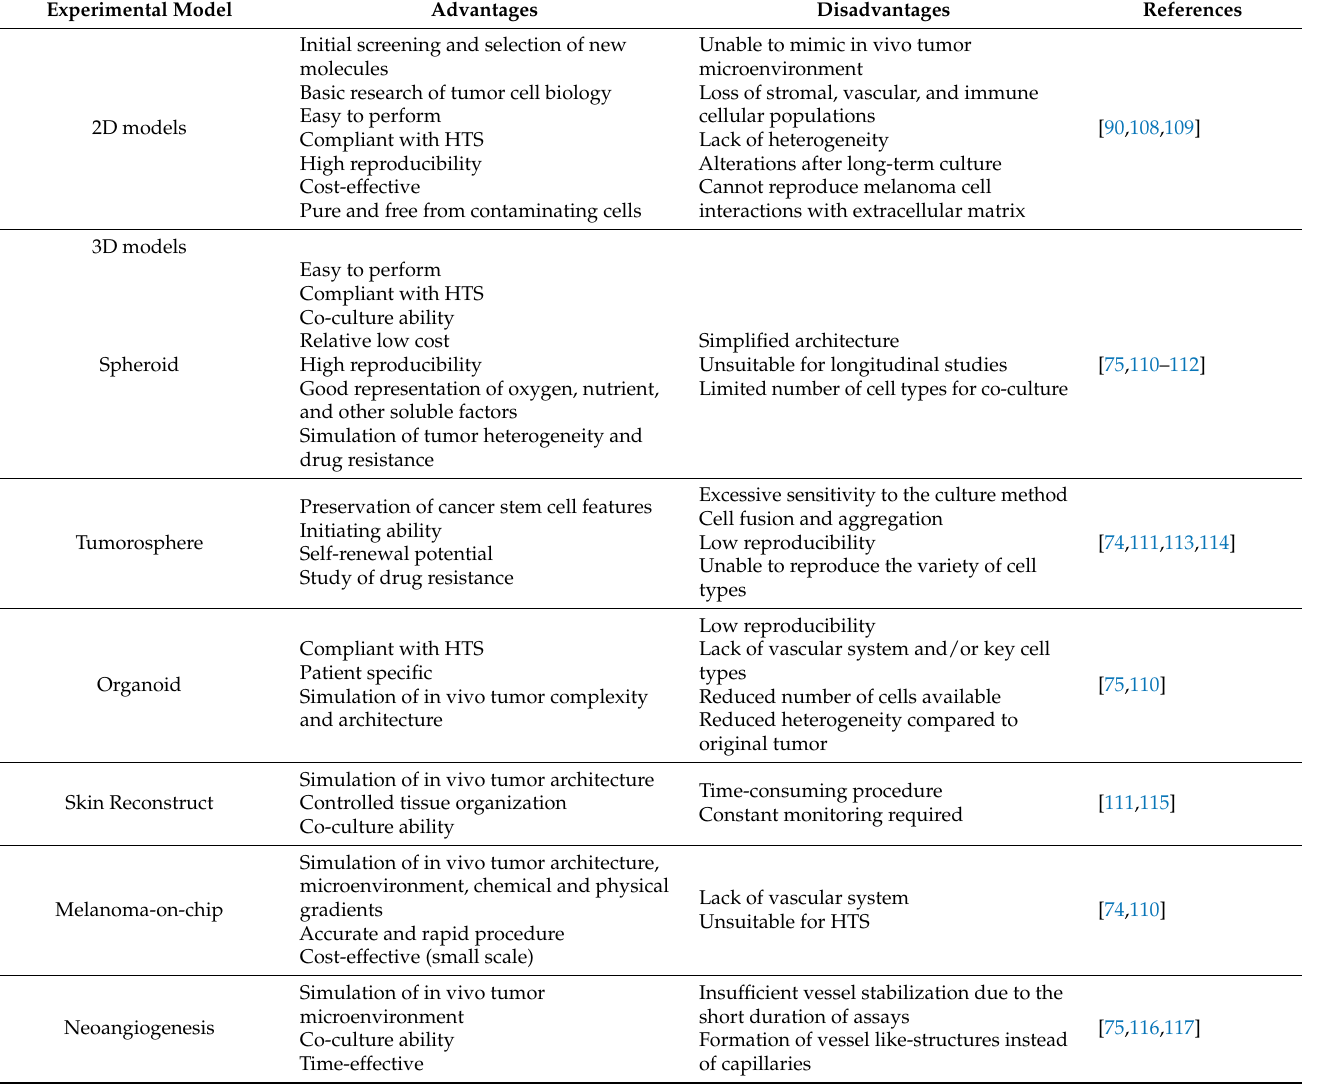
Table 2. Main in vitro melanoma models: advantages and